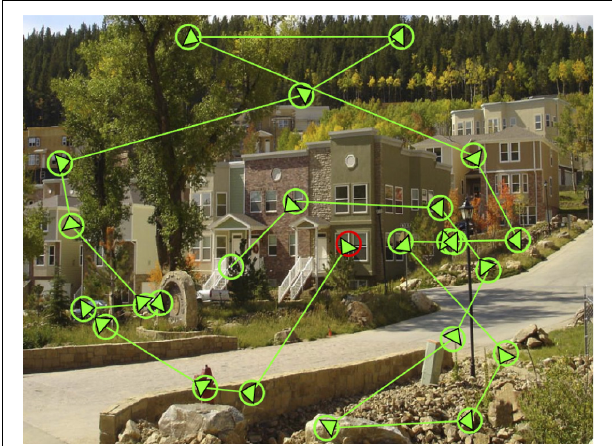
FIGURE 1 | Participant scan path in a real-world scene. The red circle represents the first fixation and the green circles represent subsequent fixations. Arrows represent the trajectory of eye movements to the next landing